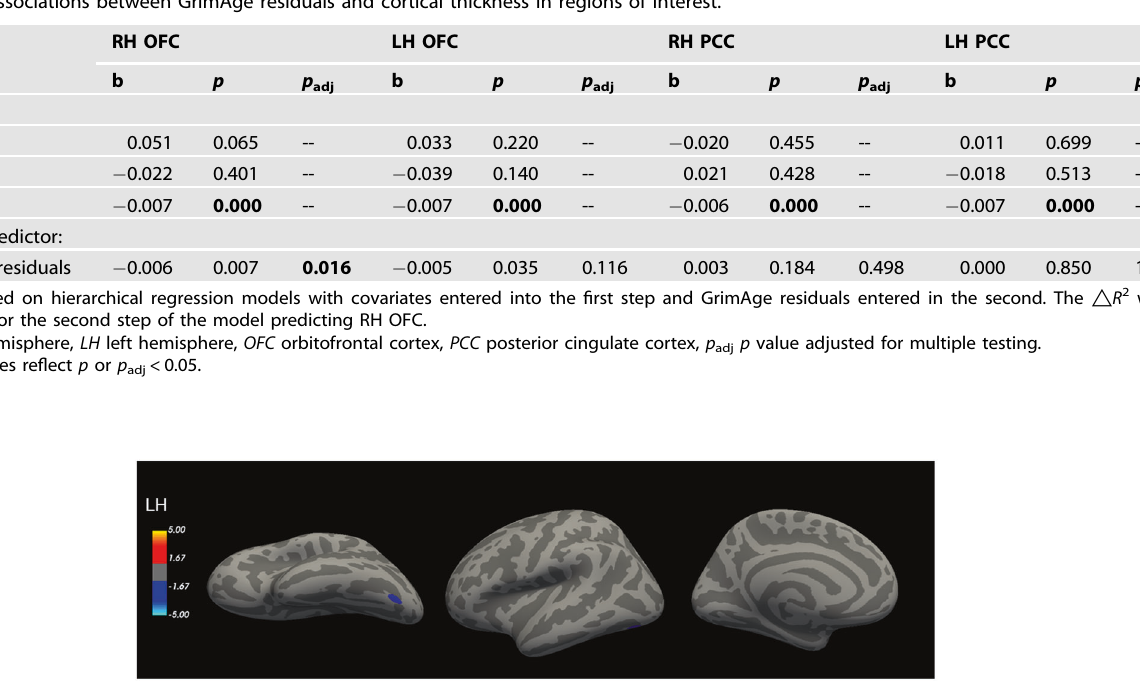
Fig. 1 Signi fi cant whole brain cortical thickness results. In a whole brain cortical thickness analysis with a vertex-wise threshold of p < 0.0001 and cluster corrected at p < 0.05, results revealed that there was a signi fi cant negative association between GrimAge residuals and the left fusiform gyrus. The color bar indicates the log 10 value for p values associated with the cluster-corrected results. LH = left